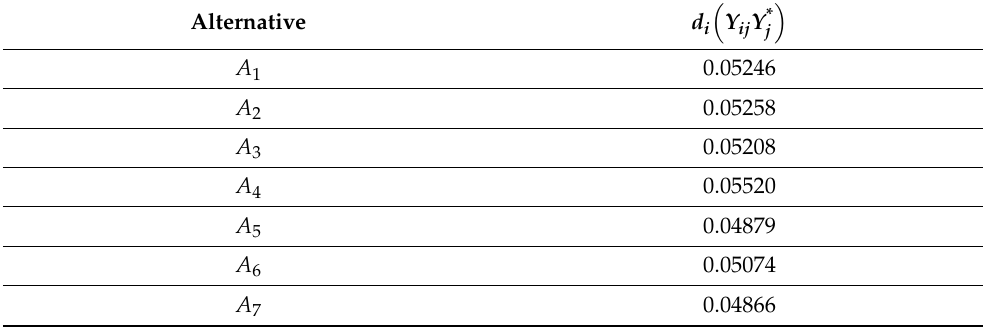
Table 10. Distance values.